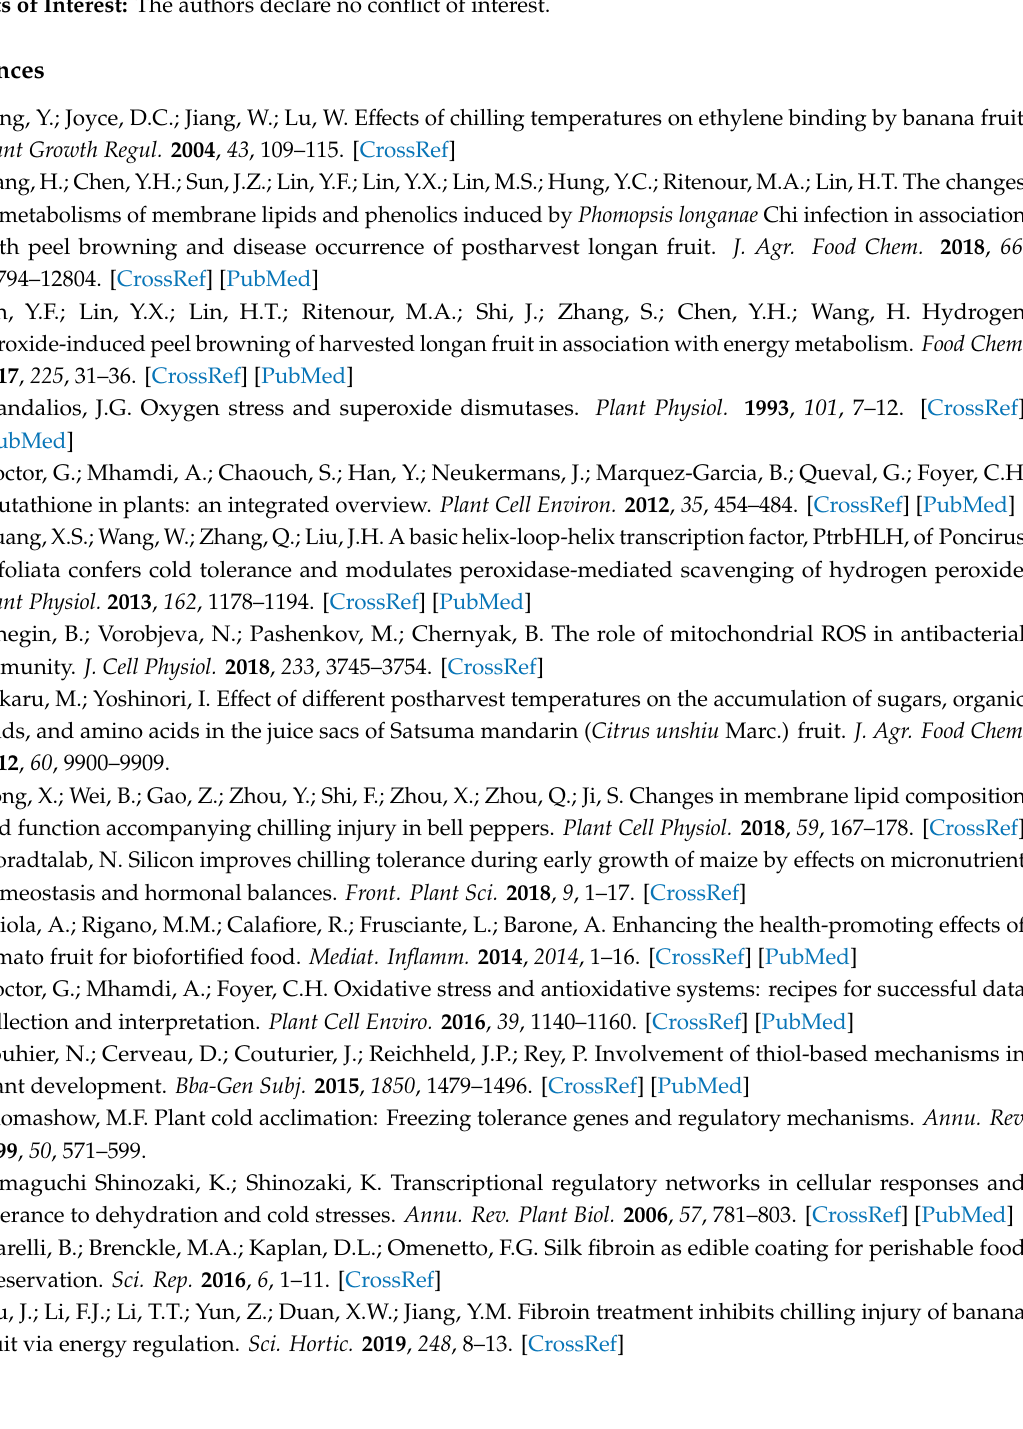
Table S1: Primers for qRT-PCR analysis in peel of banana